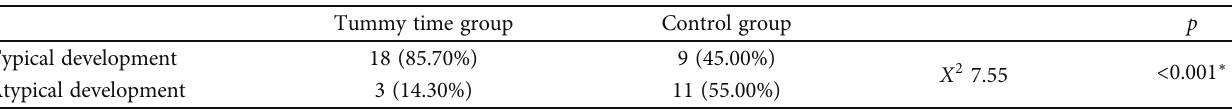
Table 3: Association between tummy time and risk of motor development delay using the survey of well-being of young children (SWYC). Tummy time group Control